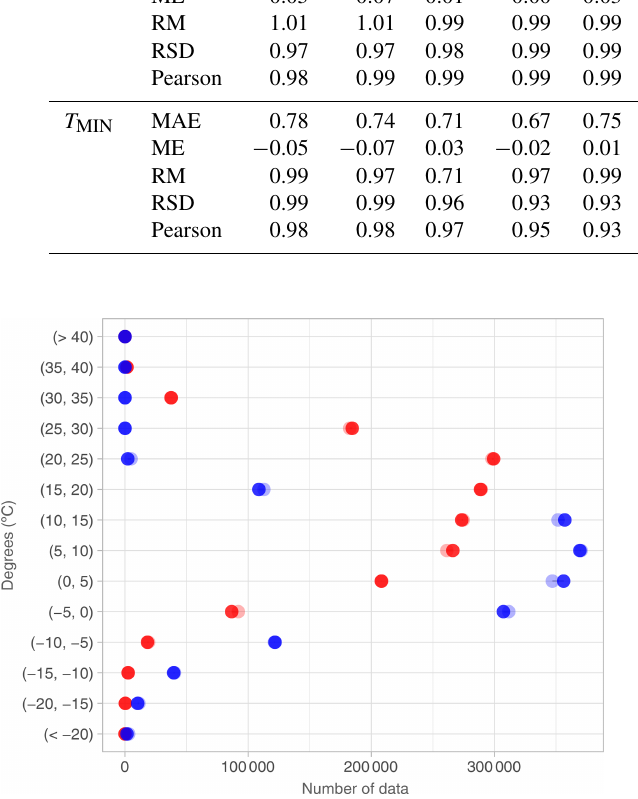
Figure 7. Comparison of frequencies by categories between ob- served (solid) and predicted (transparent) maximum (red) and min- imum (blue)